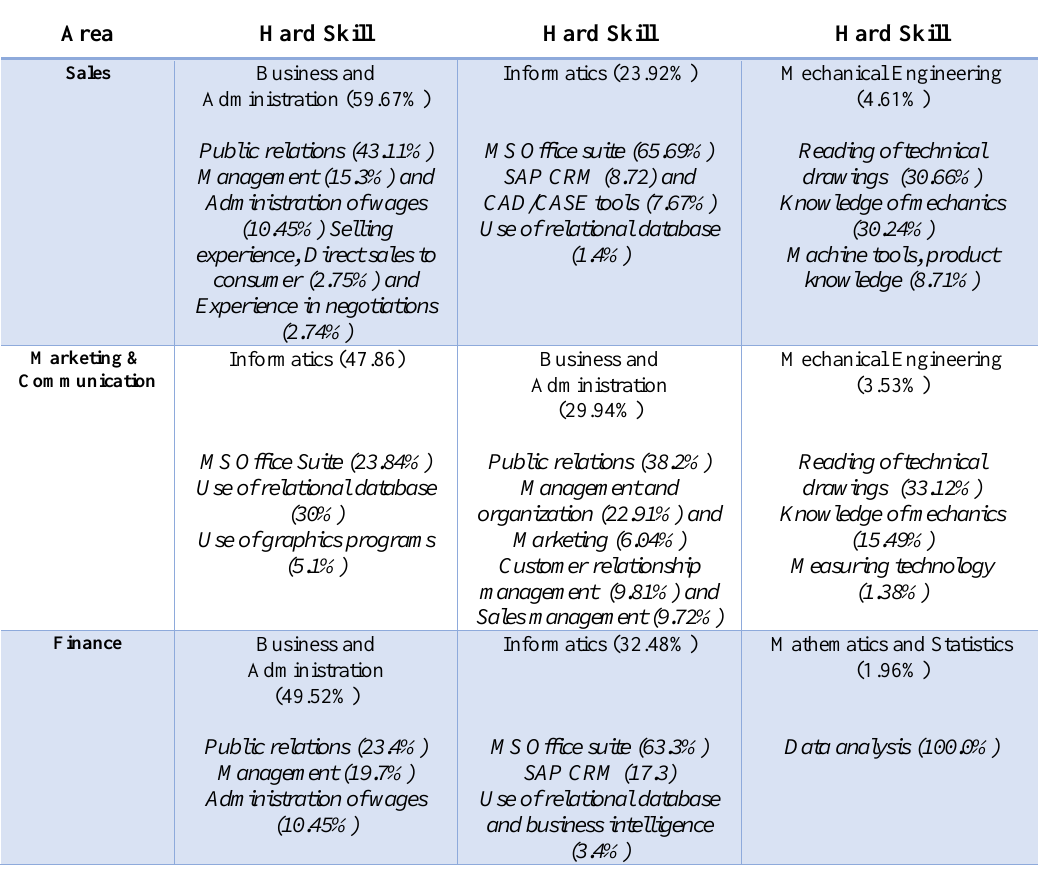
Table 2: Top 3 Hard Skills identified within the Vacancies and expressed according to the ESCO taxonomy